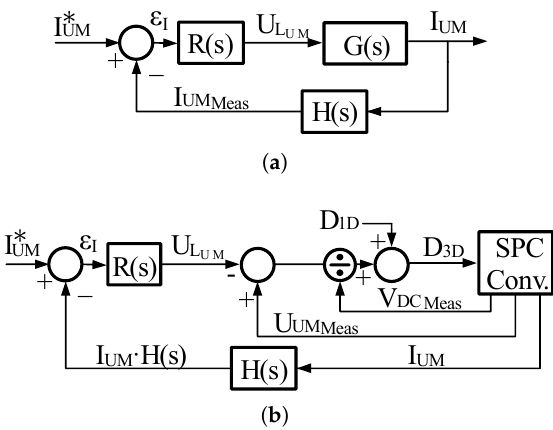
Figure 13. Control schemes: ( a ) Current control loop simplified scheme for tuning the regulator; and ( b ) implemented control scheme, obtaining D 3